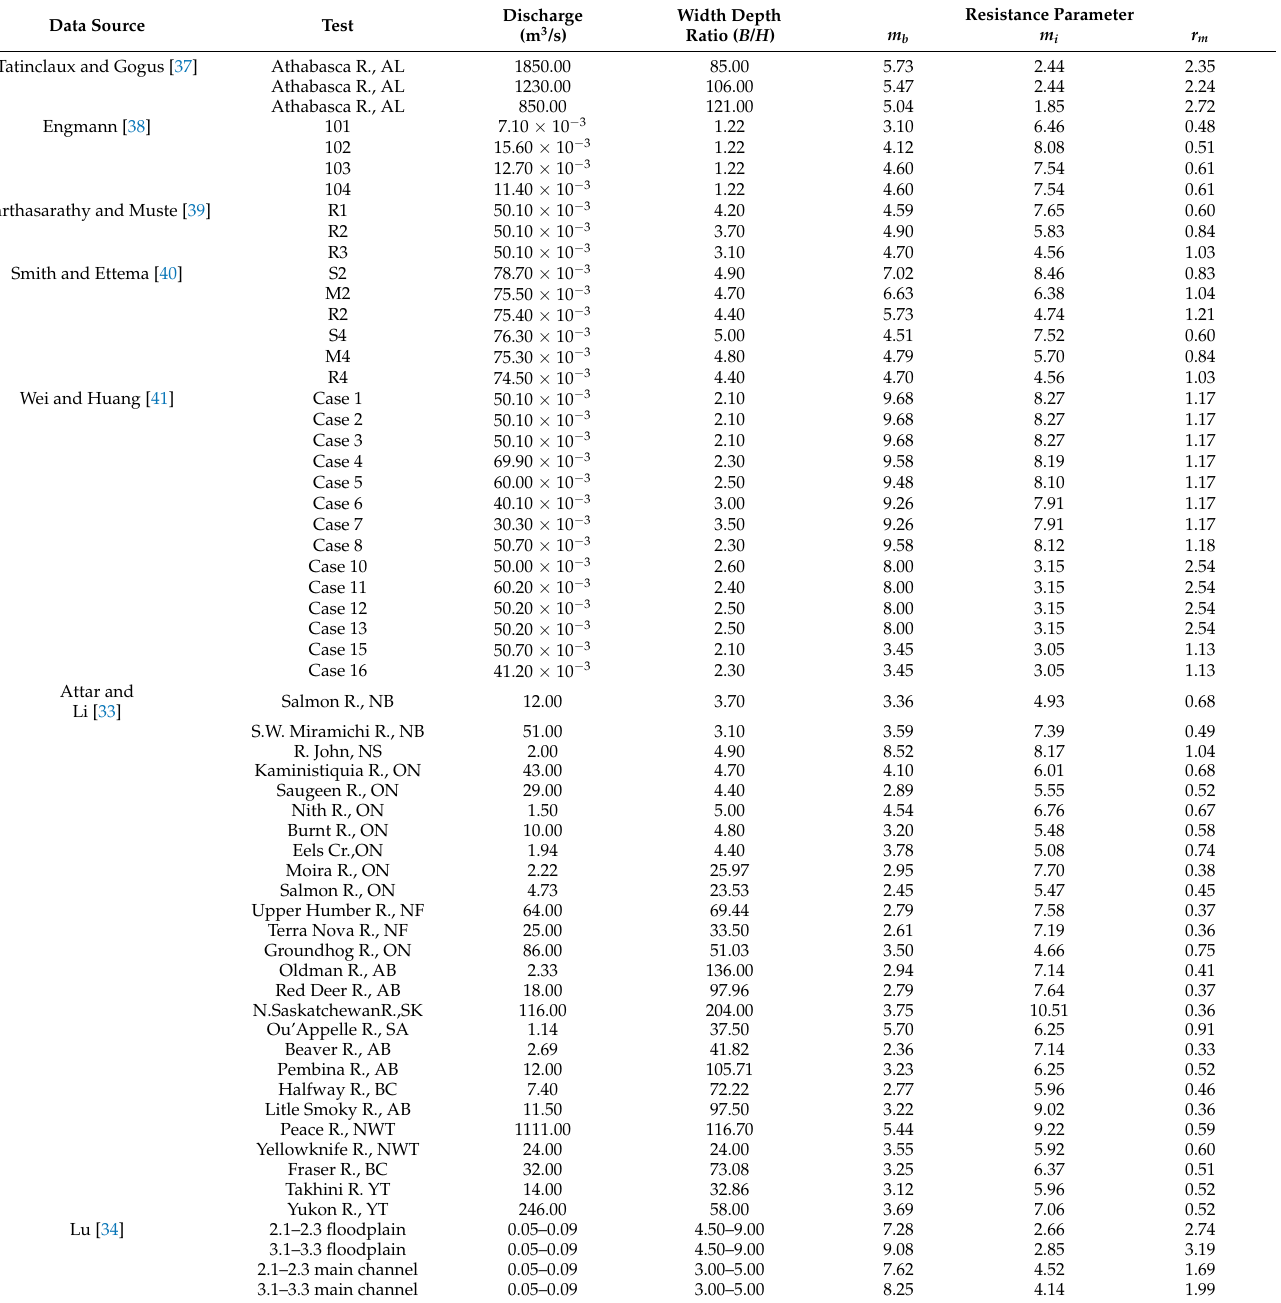
Table A1. Hydraulic parameters and flow characteristics for error estimation in ice-covered